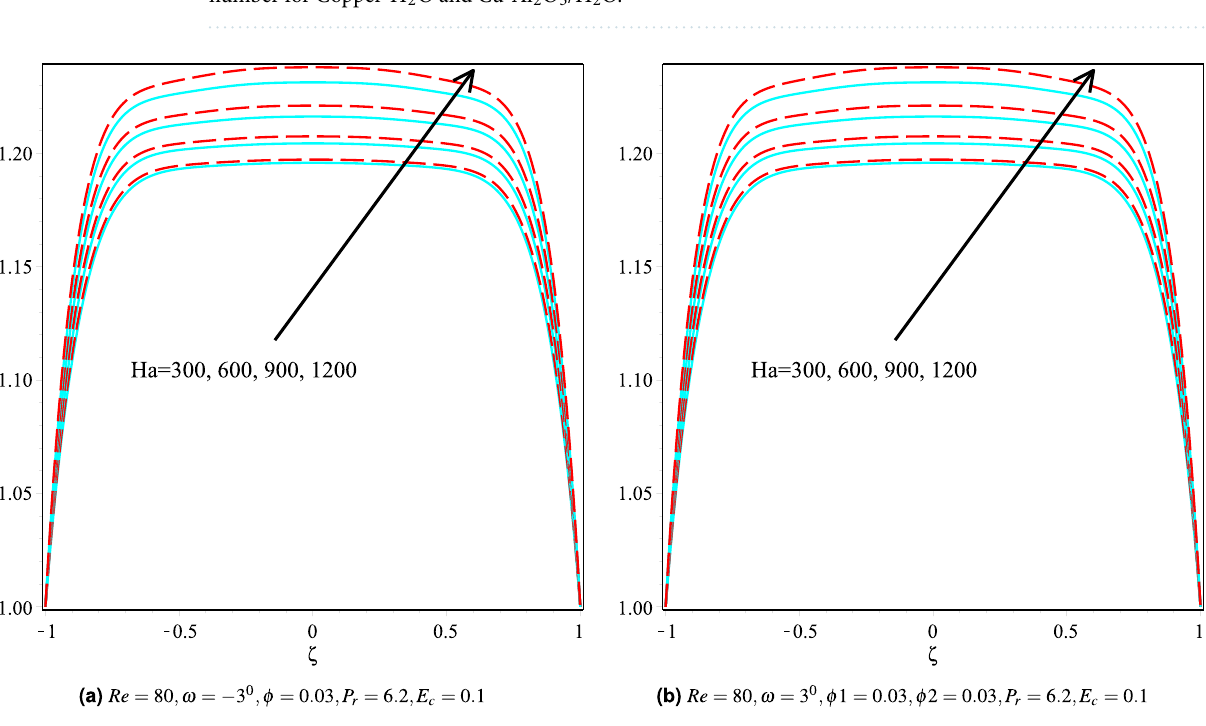
Figure 9. Velocity distribution of the fluid in converging and diverging channel with various Hartmann number for Copper-H 2 O and Cu-Al 2 O 3 /H 2 O.